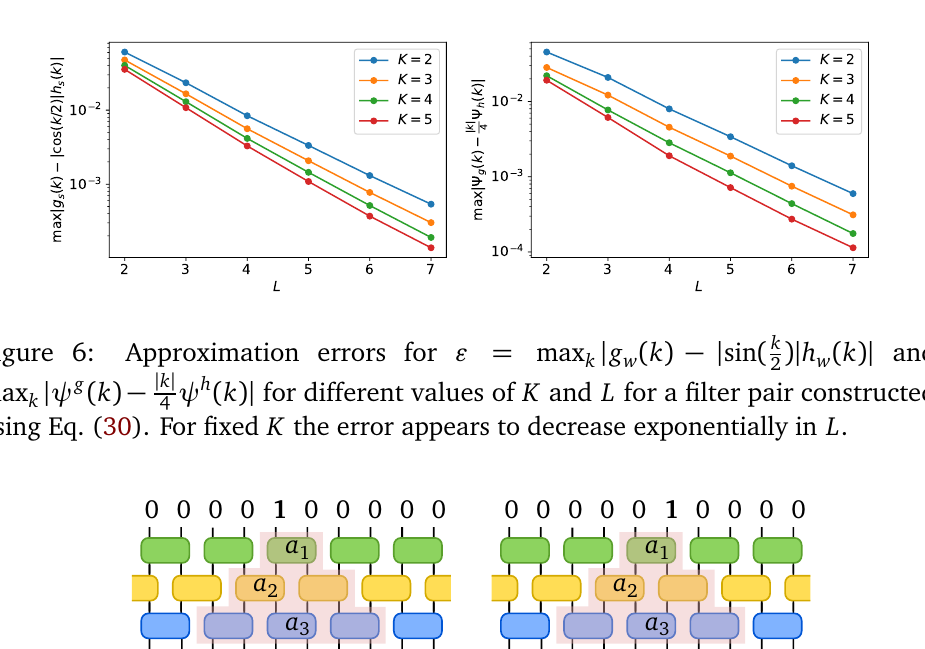
have to satisfy in i